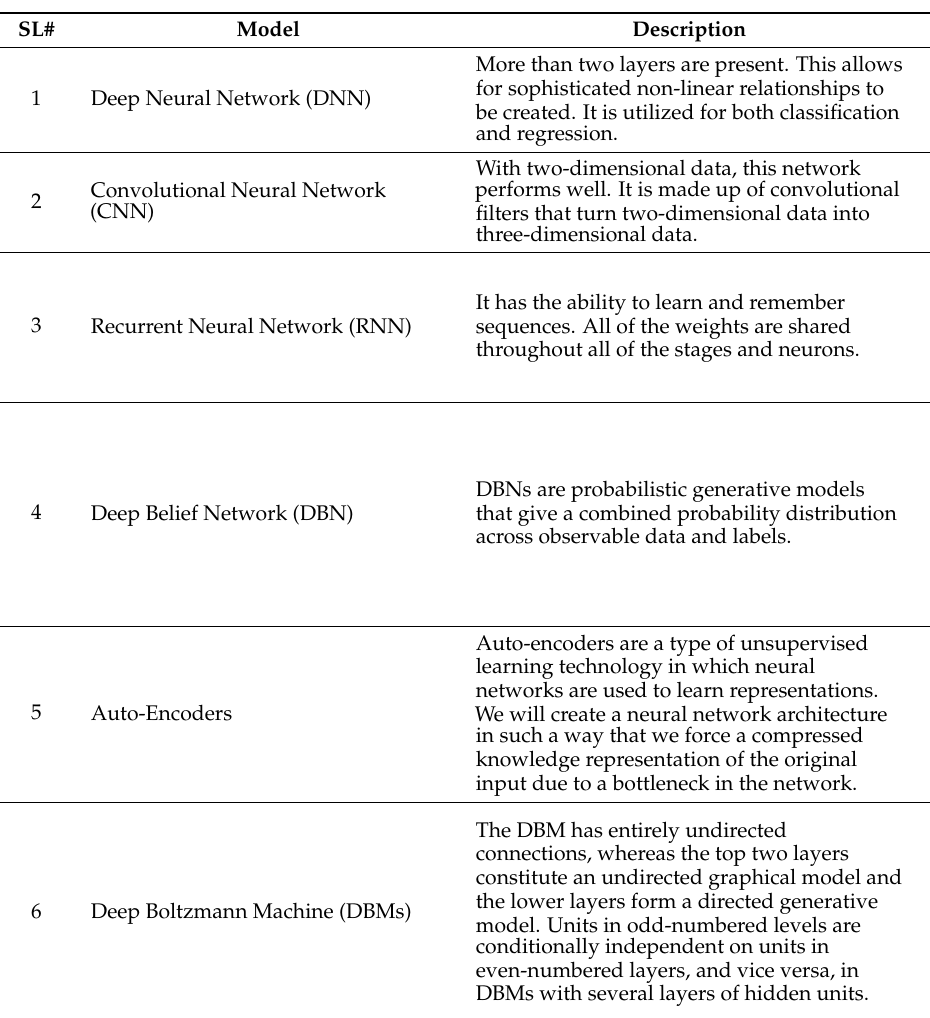
Table 9. Details of Deep Learning